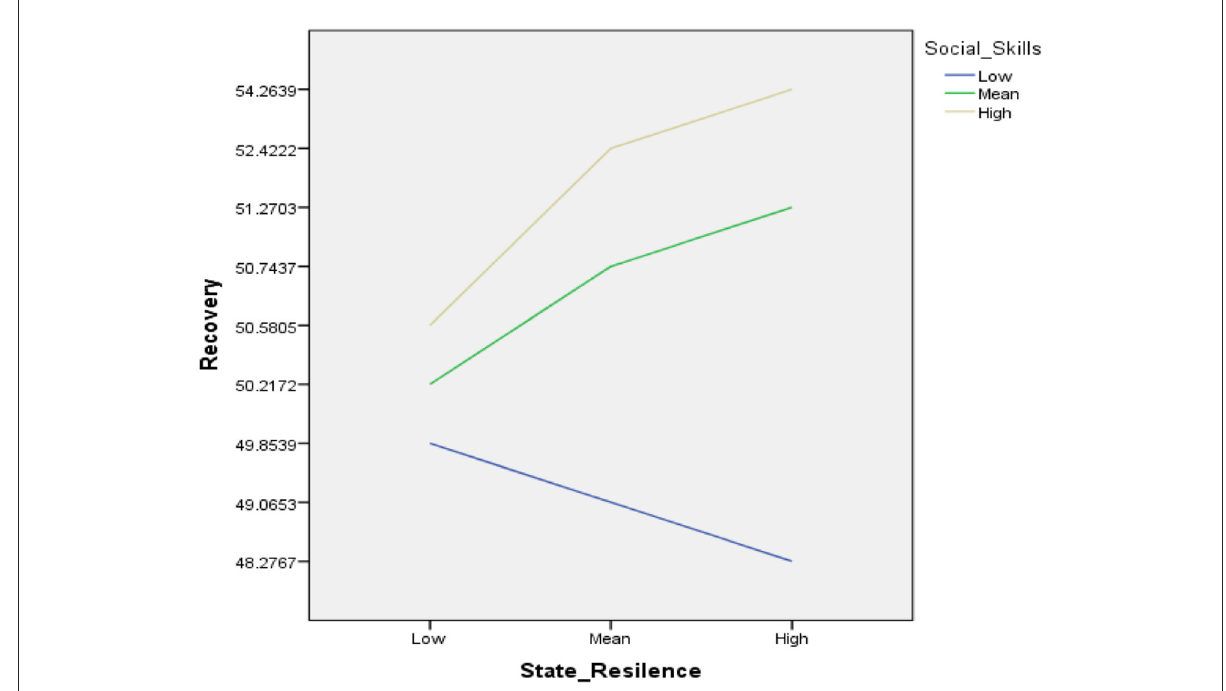
FIGURE1 Simple slope equations of regression of state resilience on recovery at three levels of social